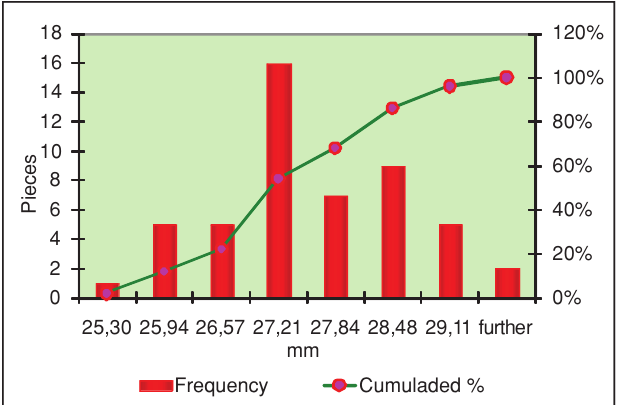
Fig. 18: The distribution of the sample with 28–30 mm size category